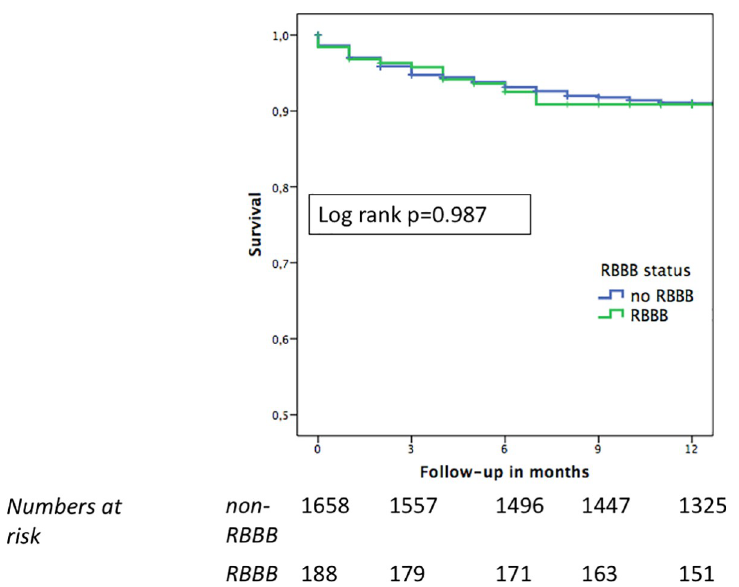
Fig 3. One-year cardiovascular survival in patients with baseline RBBB or no RBBB. During a follow-up time of 12 months, no difference in cardiovascular survival was observed between RBBB and non-RBBB patients. Abbreviations: RBBB = right bundle branch